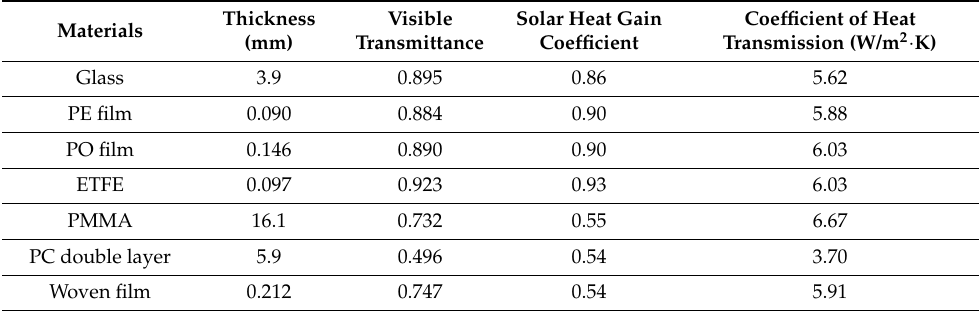
Table 5. Performance test results of smart farm covering